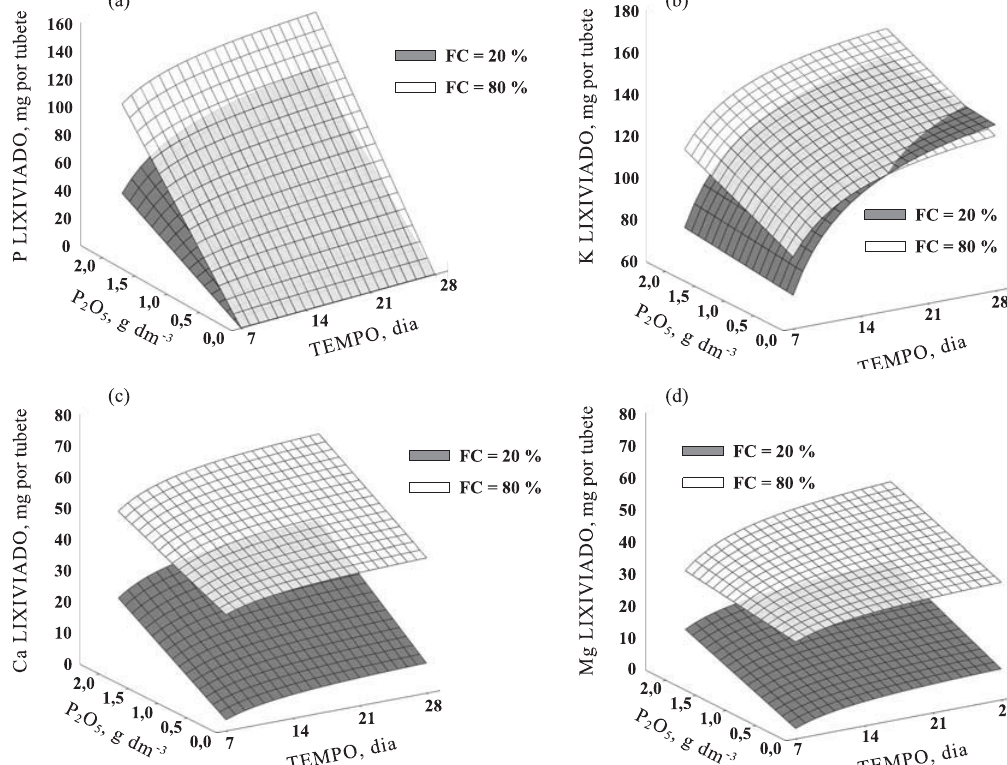
Figura 5. Lixiviação acumulada de P (a), K (b), Ca (c) e Mg (d) em função do tempo e da dose de P, para os substratos com 20 e 80 % de fibra de coco